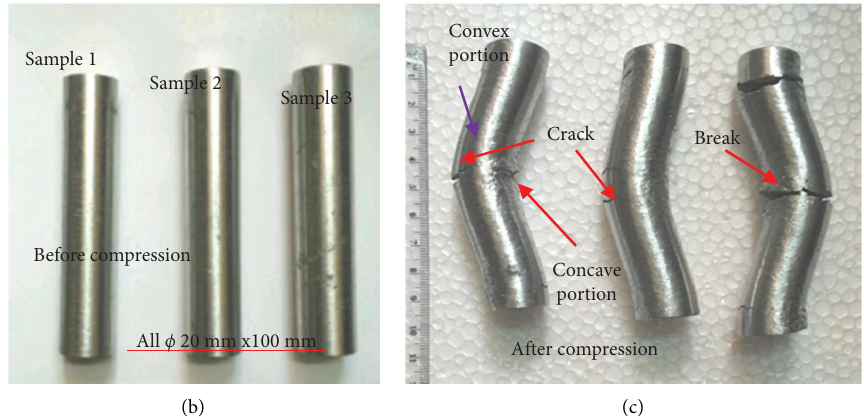
Figure 4: (a) Compression test specimen dimension; (b) specimen prepared for the compressive test; (c) samples after compression